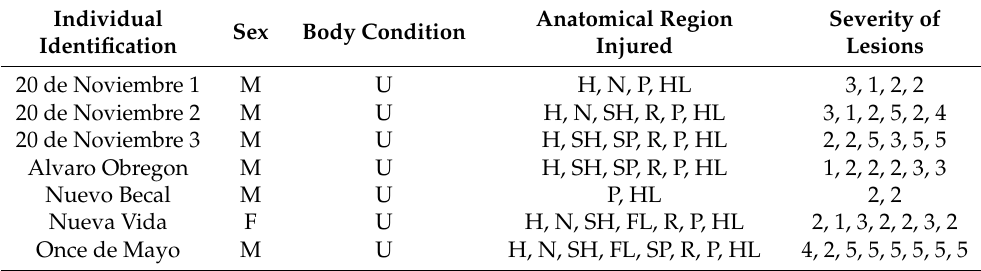
Table 3. Description of the cases of Baird’s tapirs presumably attacked by jaguars in Calakmul, Mexico. M = male, F = female, U = unhealthy, H = head, N = neck, SH = shoulder, FL = forelegs, SP = spine, R = ribs, P = pelvis and HL = hindlegs. The severity of lesions is given in the same order as the anatomical regions injured, with the following scores: minor (1), moderate (2), serious (3), severe (4), critical (5) and fatal